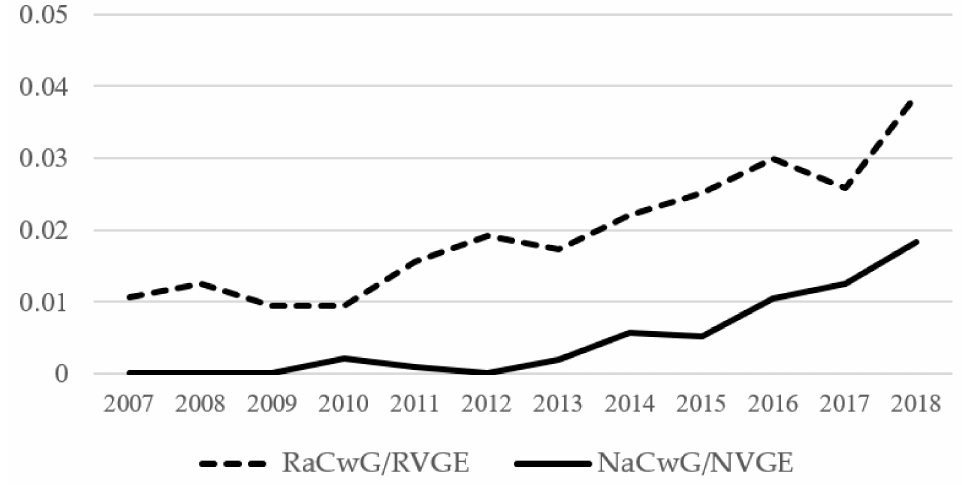
Figure 3. Annual changes in ratio of RaCwG to RVGE (Exp( β ): 1.104 (95% CI 1.032–1.182), p = 0.004) and ratio of NaCwG to NVGE (Exp( β ): 1.578 (95% CI 1.279–1.948), p < 0.001). RVGE: rotavirus gastroenteritis, RaCwG: rotavirus-associated benign convulsion with mild gastroenteritis, NVGE: norovirus gastroenteritis, NaCwG: norovirus-associated benign convulsion with mild